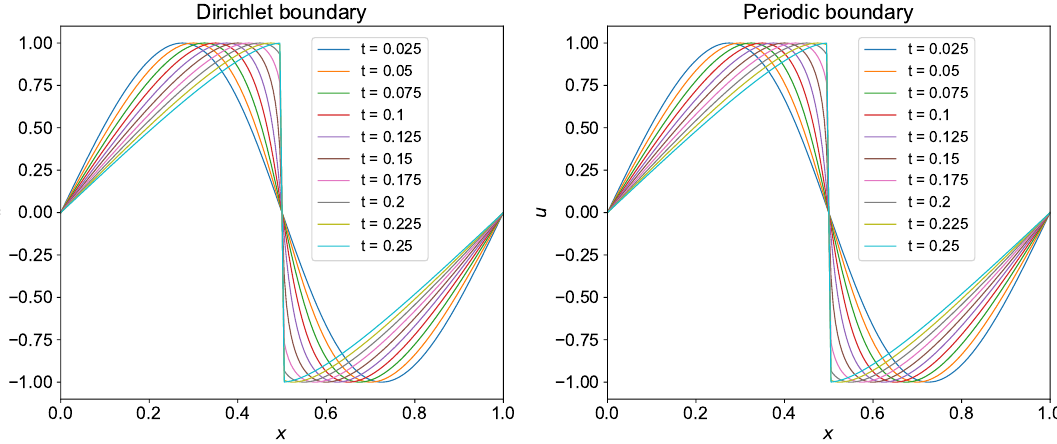
Figure 9. Evolution of shock with time for the initial condition u 0 = sin ( 2 π x ) using CRWENO